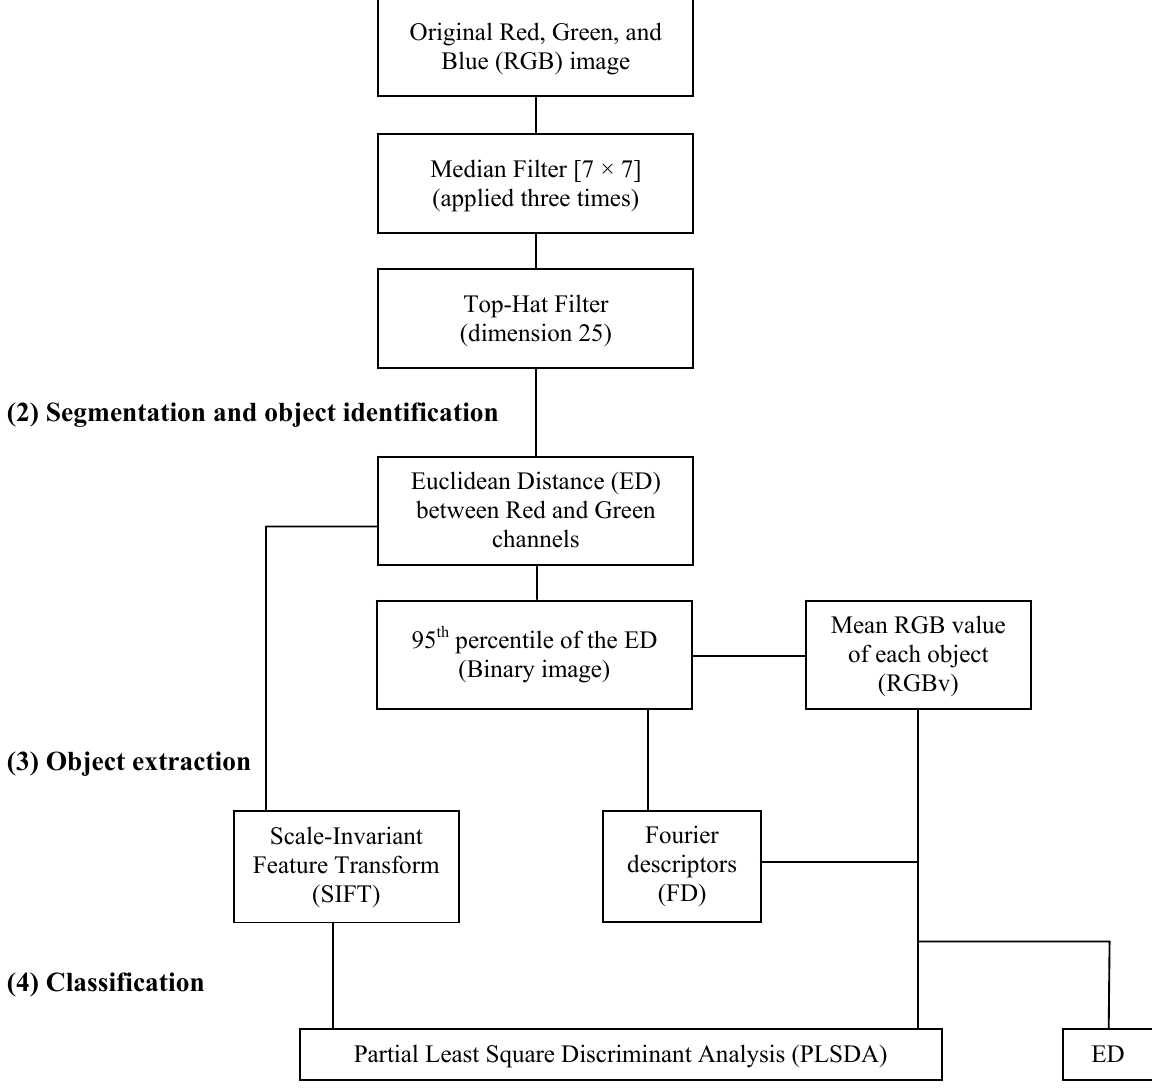
Figure 1. Flowchart detailing the customized image analysis protocol for the automated detection of squat lobsters ( Munida quadrispina ) with the VENUS cabled observatory imaging